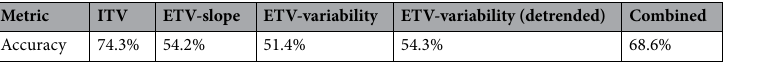
Table 1. Classification accuracy. The cross-validated classification accuracy indicating how well the ASD group can be separated from the control group using each individual variable and all variables combined. The best accuracy was achieved using ITV, reaching a cross-validated accuracy of 74.3%.